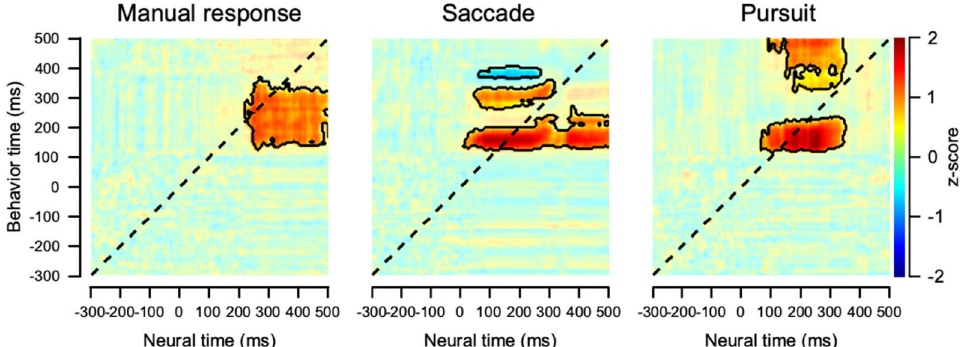
Figure 5. Cross-temporal correlation between neural and behavior direction discriminations. Clusters with significant correlations (that were significantly larger than the baseline) were marked with black contour lines (two-sided cluster-based permutation test, p < 0.01). The dotted diagonal indicates correlations between EEG and eye velocities obtained concurrently. Therefore, the significant correlation in the upper-left of the diagonal shows the neural direction discriminability preceding the behavioral direction discriminability. The lower-right area of the diagonal shows the